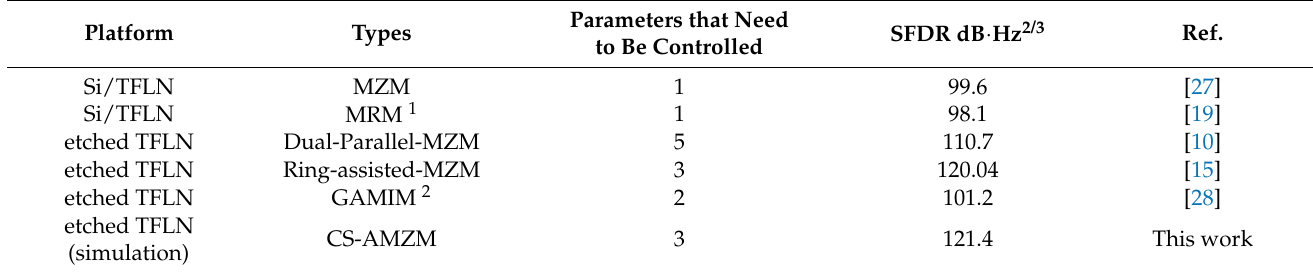
Table 3. Comparison of the reported modulators on TFLN